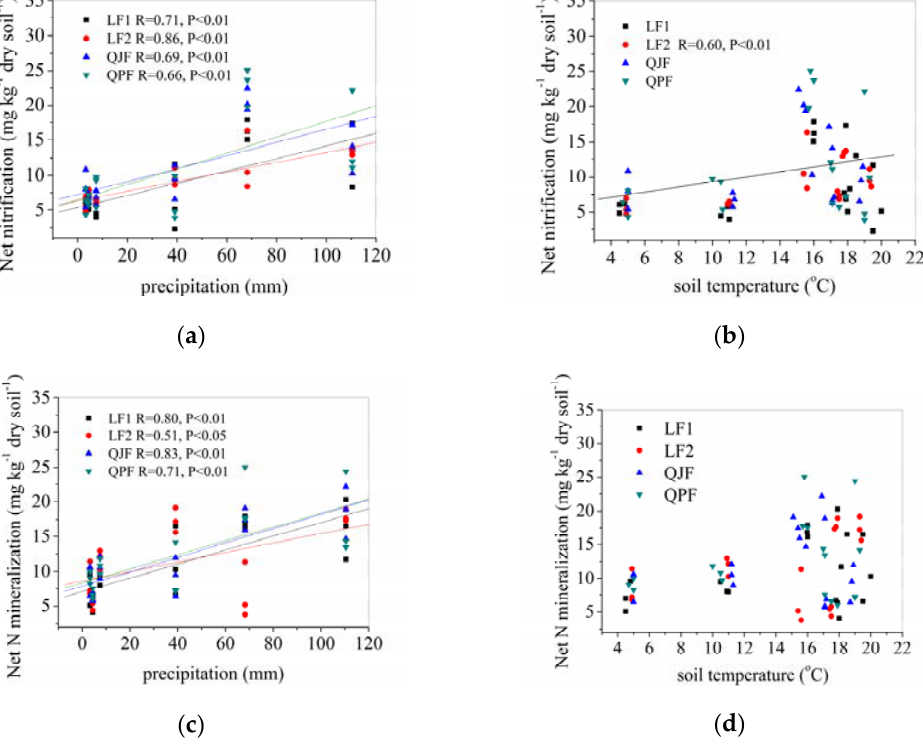
Figure 5. Correlations for nitrification rates to precipitation ( a ) and soil temperature ( b ); correlations for N mineralization rates to precipitation ( c ) and soil temperature ( d ); the precipitation was amount of precipitation per one month and soil temperature was the average for one month.